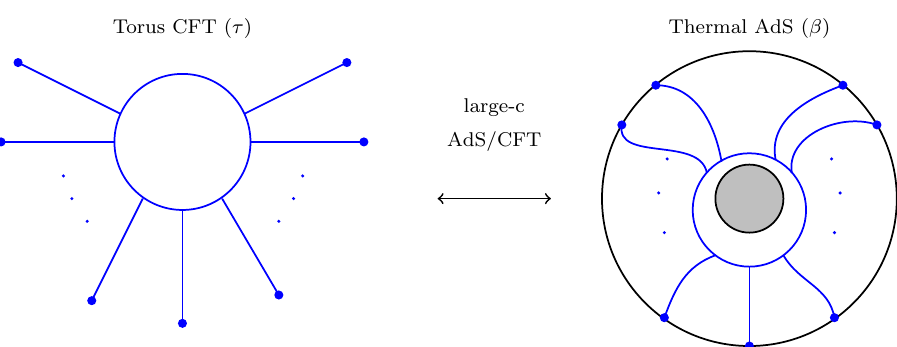
Figure 2 . n -point s -channel conformal blocks with the modular parameter (cid:28) in the s -channel holographically realized as the necklace graph on two-dimensional slice of the thermal AdS. Time runs along the non-contractible cycle t (cid:24) t + (cid:12) . Primary operators are inserted at x i at the boundary. These points are mapped to boundary attachment points y i in the